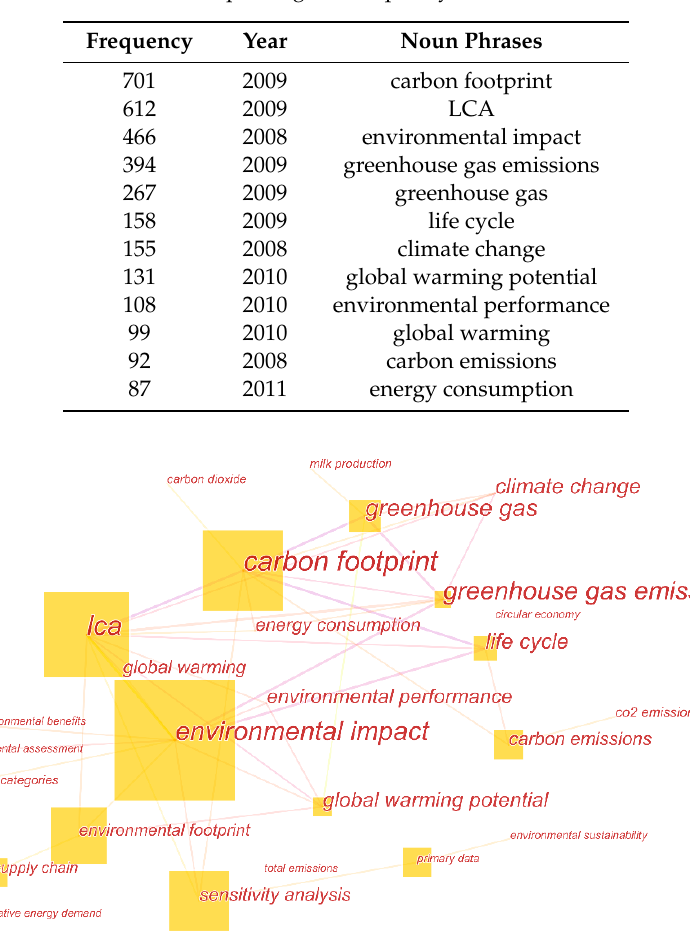
Table 1. Top 12 highest frequency noun terms.